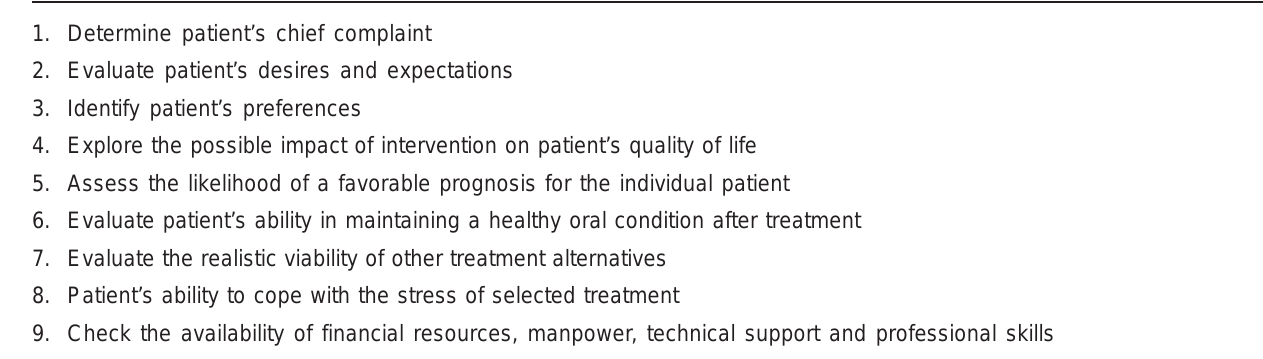
TABLE 2- Practitioners’ checklist of multidimensional aspects of prosthetic needs assessment and treatment decisions (see details in